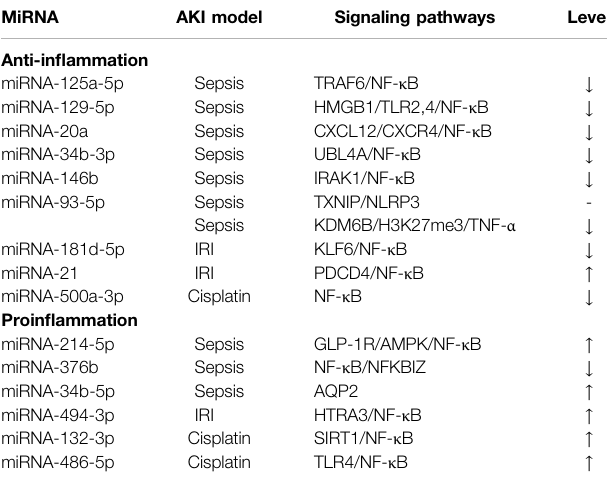
TABLE 1 | Role of miRNAs in in fl ammatory response of AKI. MiRNA